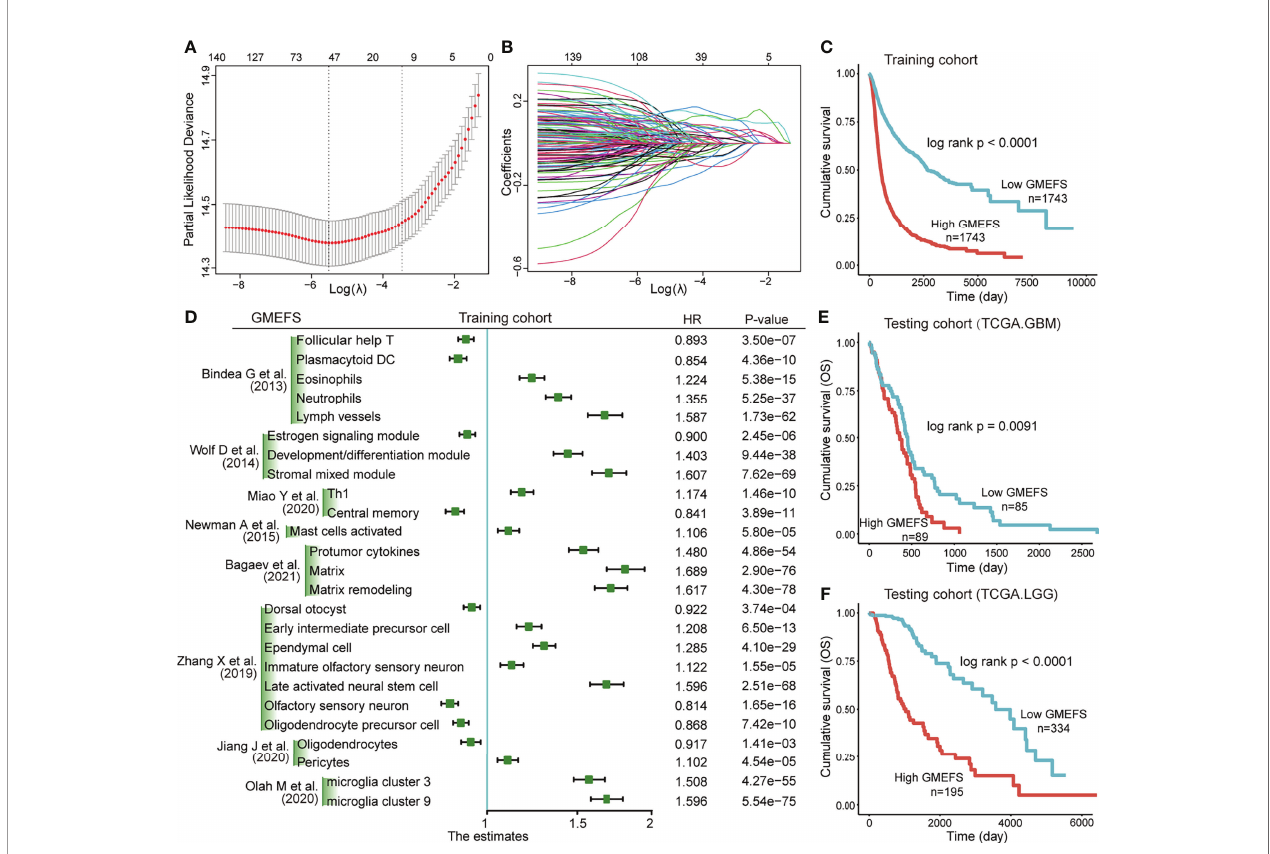
FIGURE 1 | Construction and validation of the Glioma MicroEnvironment Functional Signature (GMEFS) model. (A) Partial likelihood deviance revealed by the Least Absolute Shrinkage and Selection Operator (LASSO) regression model in the 10-fold cross-validation. The vertical dotted lines were drawn at the optimal values by using the minimum and 1-SE criteria. (B) LASSO coef fi cient pro fi les of 25 selected immune cell signatures in the 10-fold cross-validation. (C) Kaplan – Meier estimate of the overall survival for the training cohorts. (D) The forest plot of the associations between the in fi ltrate levels of 25 immune cell signatures and overall survival in the training cohort. The HR, 95% CI, and P-value were determined by univariate Cox regression analysis. Kaplan – Meier estimate of the overall survival for two testing cohorts, The Cancer Genome Atlas-glioblastoma (TCGA-GBM) (E) and The Cancer Genome Atlas-low-grade glioma (TCGA-LGG) (F) , divided by the GMEFS